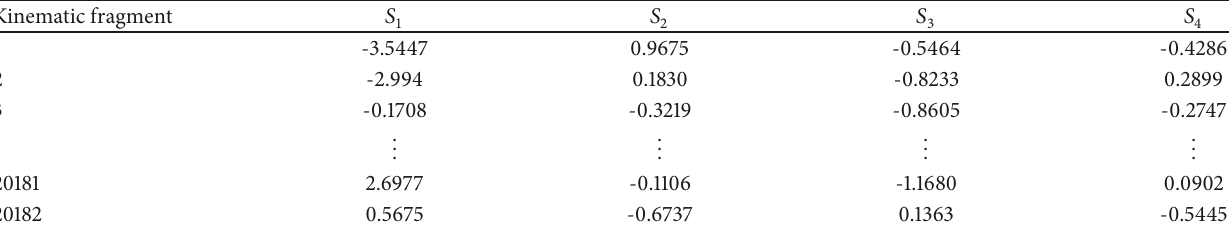
Table 4: Principal component score matrix.